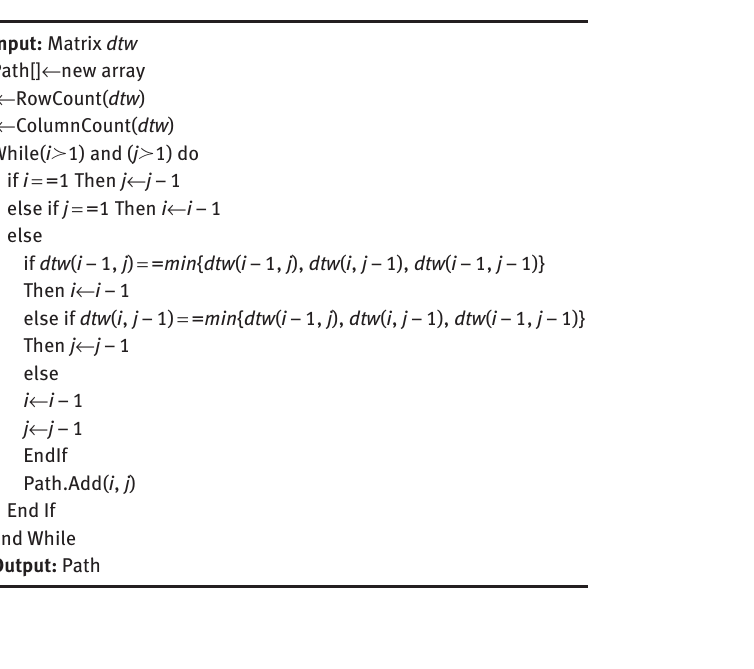
Algorithm 2: OptimalWarpingPath ( dtw